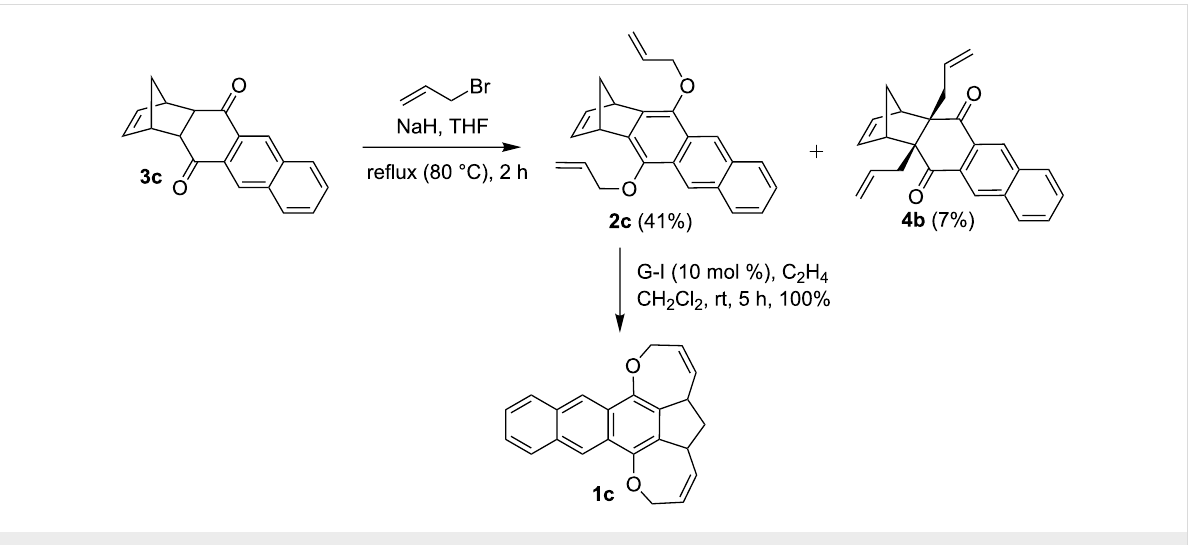
Scheme 3: Synthesis of the hexacyclic compound 1c using